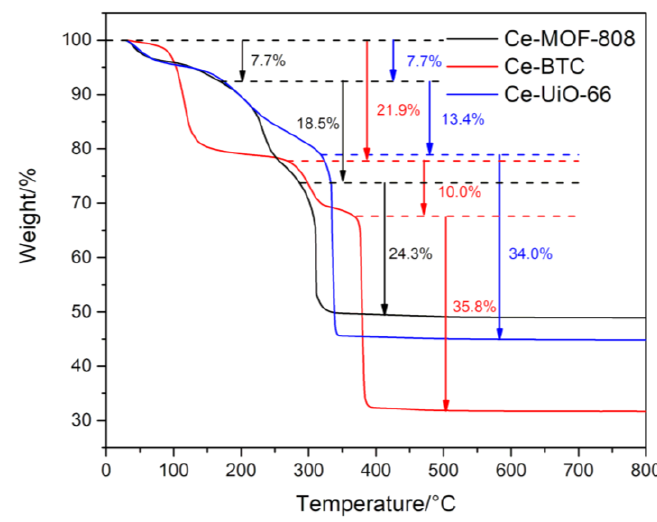
Figure 4. The TGA profiles of the Ce-MOFs.